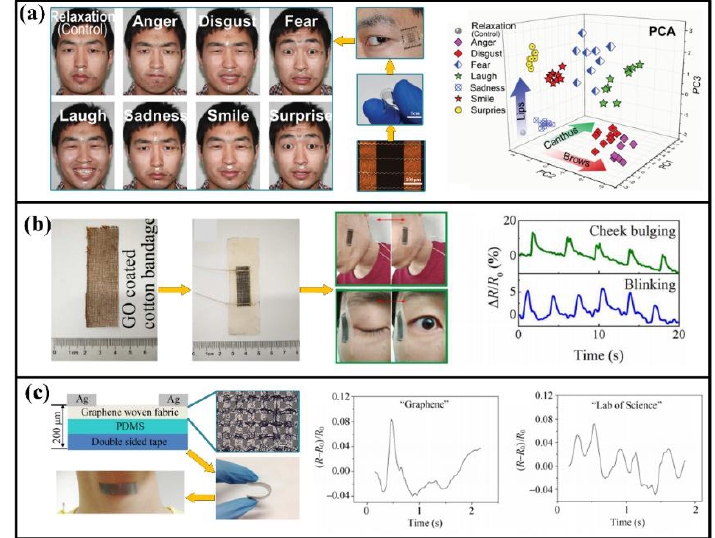
Figure 3. Detected indicators in face and throat: ( a ) Facial expression; ( b ) blinking and cheek bulging; ( c ) vocalization of “graphene” and” lab of science”. Reproduced from [9] with permission of WILEY. Adapted with permission from [72], Copyright (2017) American Chemical Society. Adapted with permission from [10], Copyright (2015) Springer.